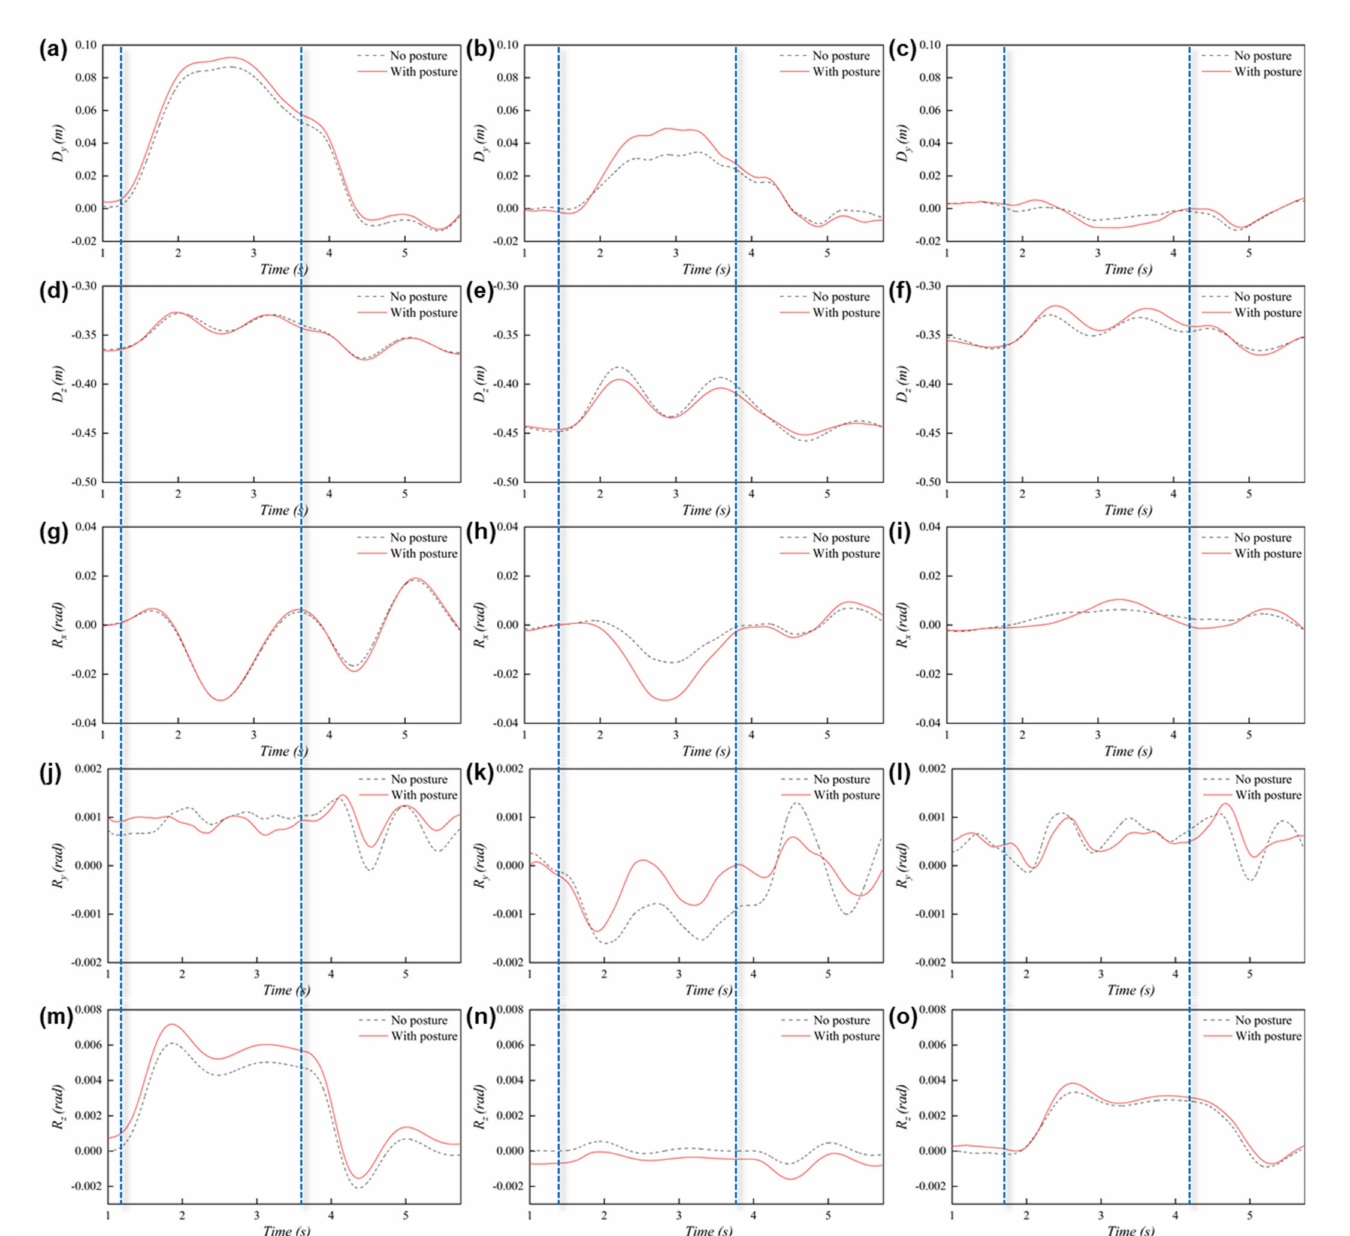
Figure 16. Time-varying values of the indicators along five degrees of freedom of the head car with various wind barriers: ( a ) D y of the leading car; ( b ) D y of the middle car; ( c ) D y of the trailing car; ( d ) D z of the leading car; ( e ) D z of the middle car; ( f ) D z of the trailing car; ( g ) R x of the leading car; ( h ) R x of the middle car; ( i ) R x of the trailing car; ( j ) R y of the leading car; ( k ) R y of the middle car; ( l ) R y of the trailing car; ( m ) R z of the leading car; ( n ) R z of the middle car; ( o ) R z of the trailing